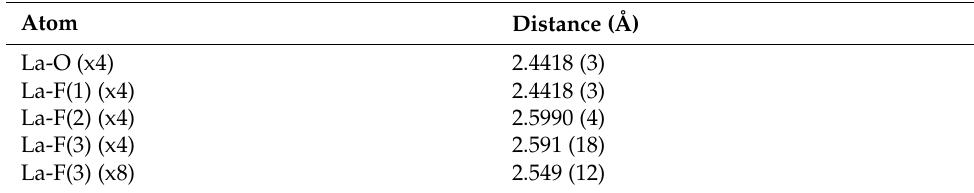
Table 3. Selected interatomic distances for LaO 0.65 F 1.7